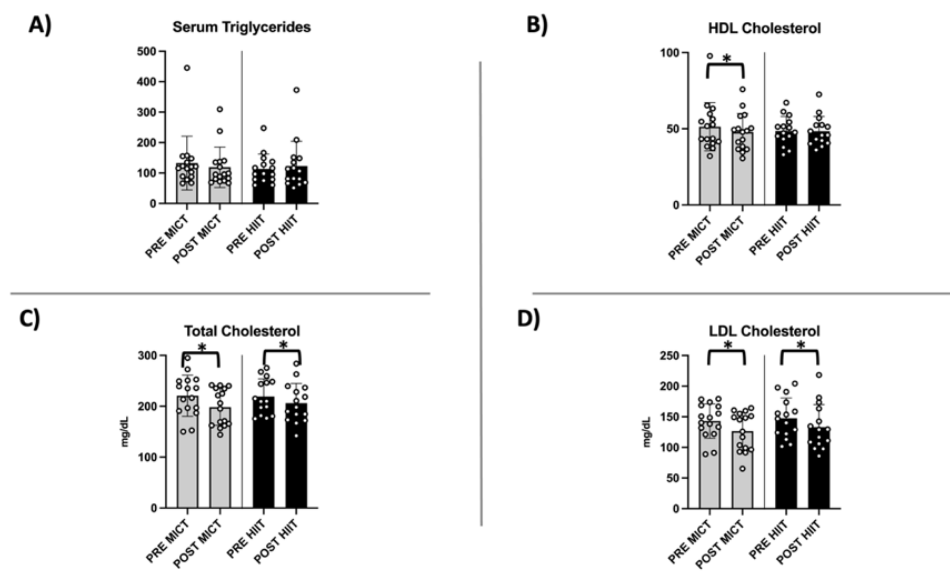
Figure 6. Circulating lipid profile. The data are shown as the average ± standard deviation. Com- parison between MICT and HIIT groups in levels of ( A ) serum triglycerides, ( B ) HDL cholesterol ( p ‐ value 0.045 for MICT), ( C ) total cholesterol ( p ‐ value 0.01 and 0.03, respectively for MICT and HIIT), and ( D ) LDL cholesterol ( p ‐ value 0.02 and 0.01, respectively for MICT and HIIT) is shown. * = p ‐ value < 0.05.